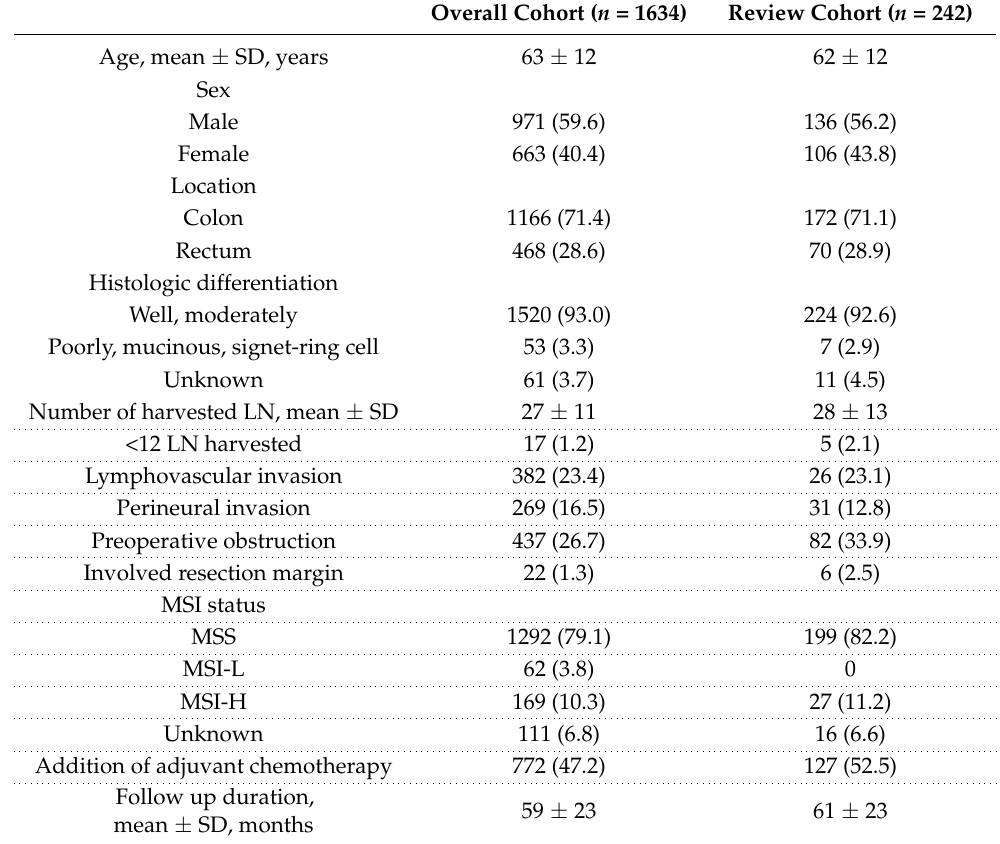
Table 1. The clinicopathological characteristics of patients with pT3N0 colorectal cancer in the overall and review